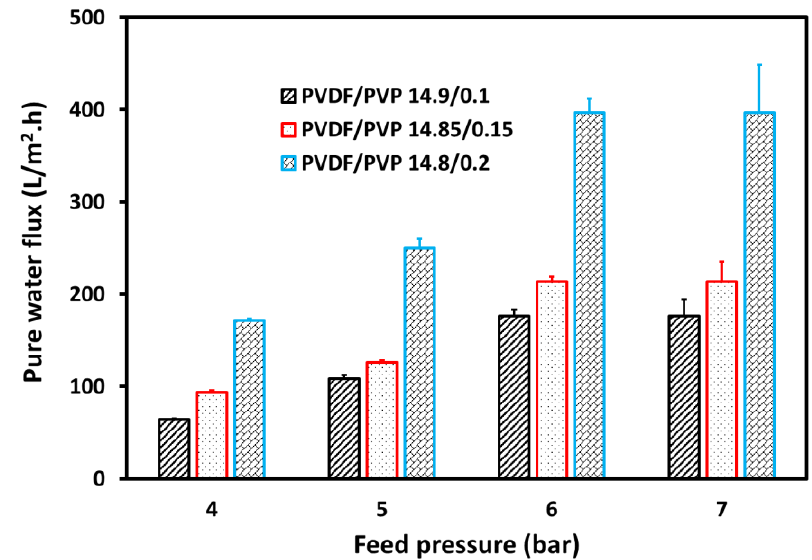
Figure 5. Water flux at various feed pressures in the UF process for pure water.